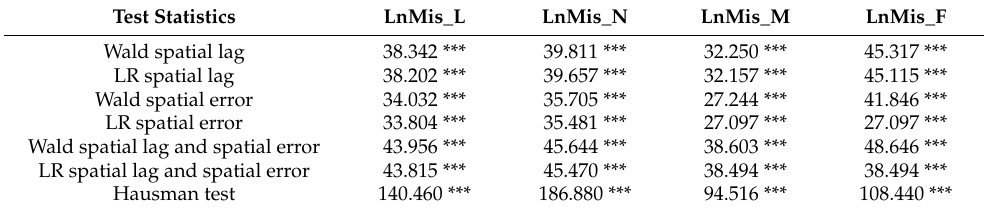
Table 7. LR, Wald and Hausman test